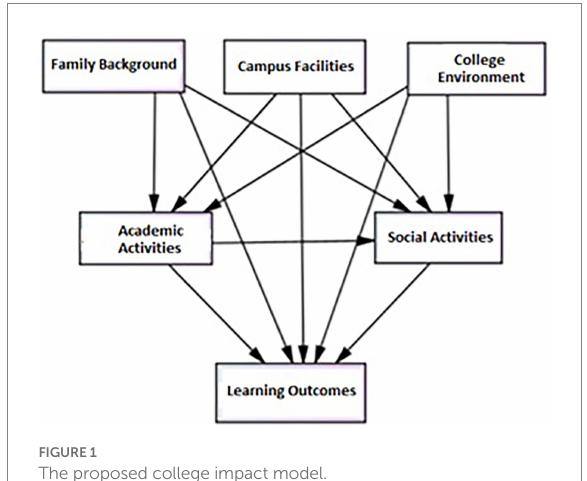
FIGURE 1 The proposed college impact